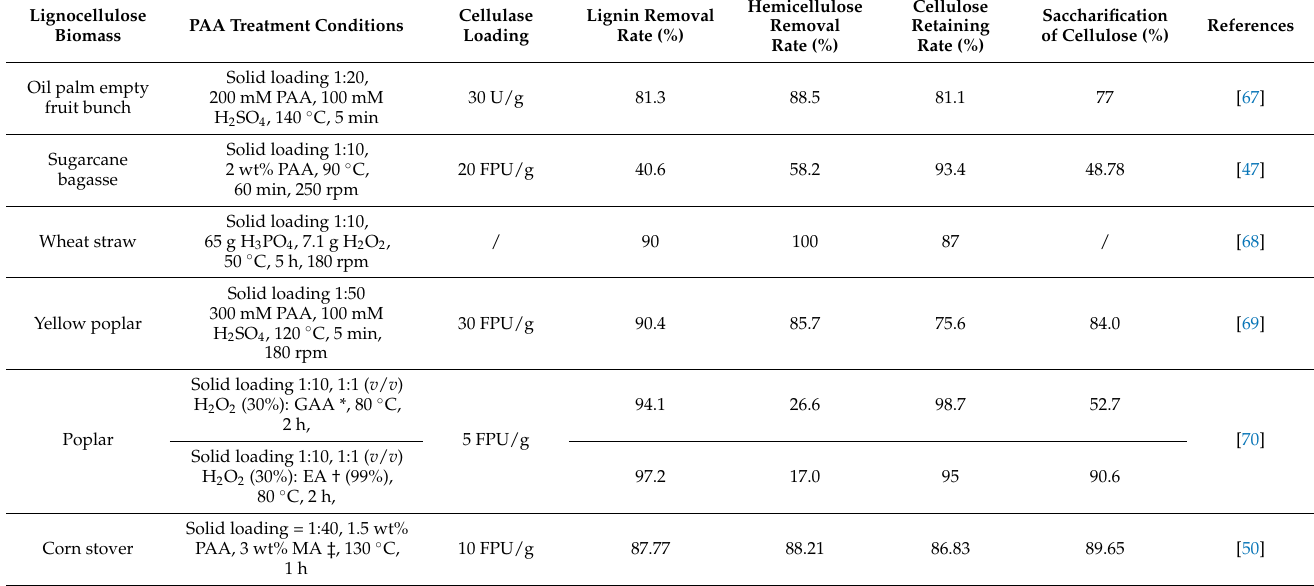
Table 4. PAA pretreatment for lignocelluloses fractionation and its effectiveness.